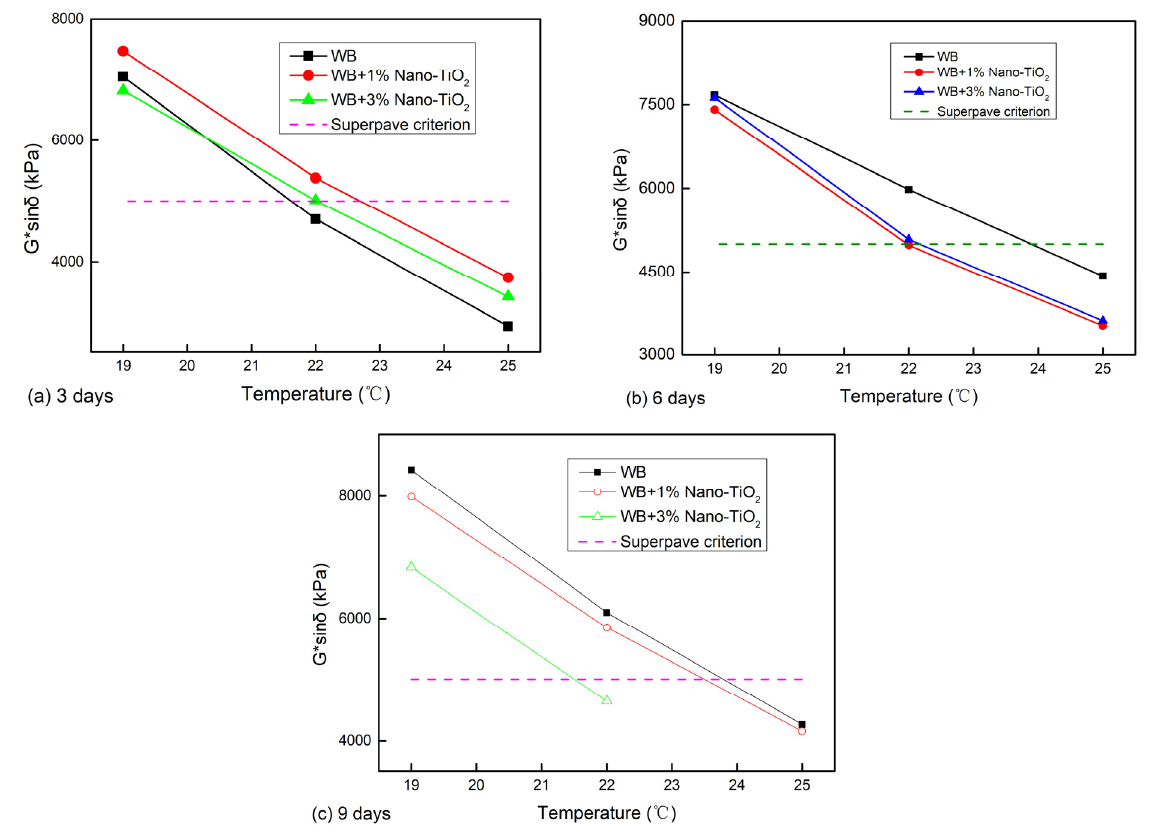
Figure 4. G *sin δ values of UV-aged binders: ( a ) 3 days; ( b ) 6 days [21] ; ( c ) 9 days.